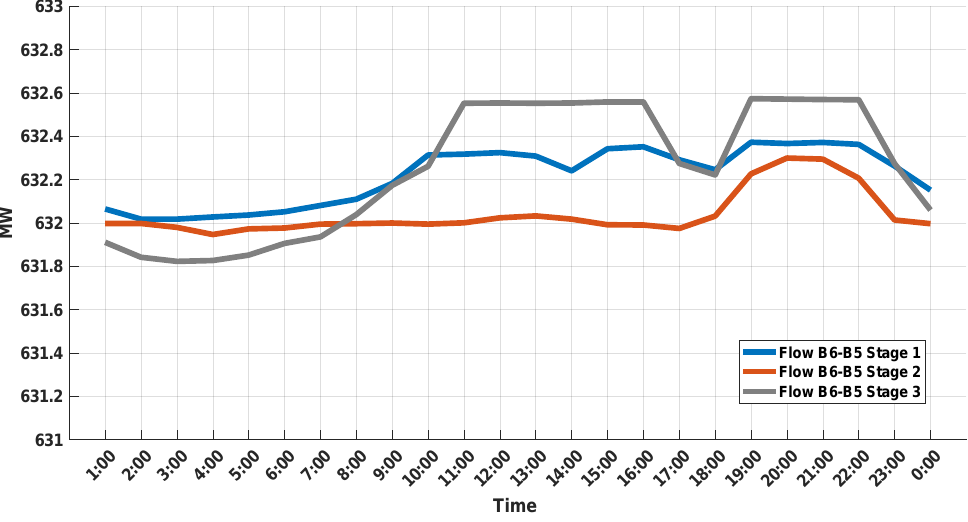
Figure 29. Power flow variation from bus 6 to bus 5 (MW).